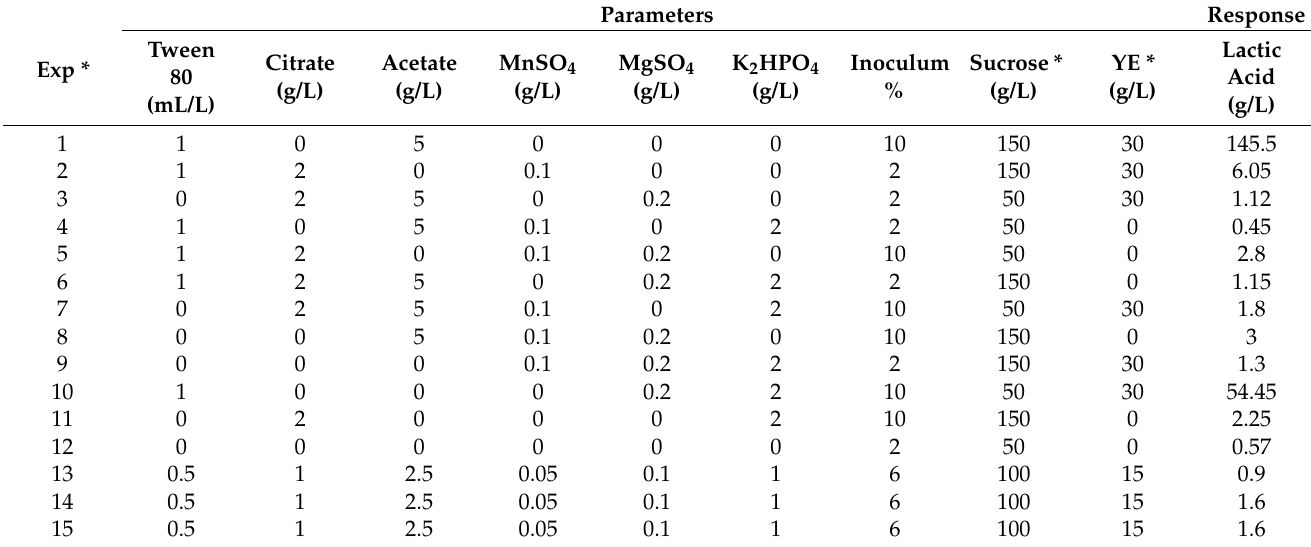
Table 3. Plackett–Burman design matrix with real values and response (lactic acid production) after 24 h of